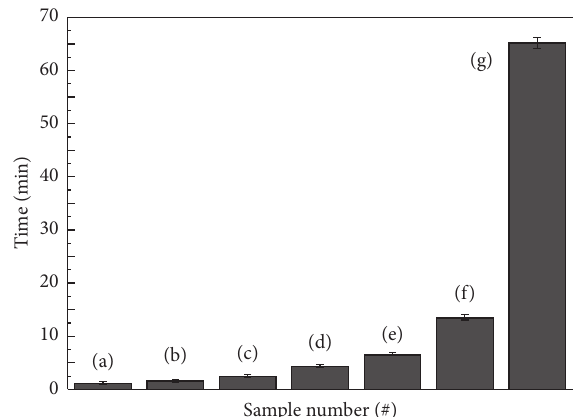
Figure 13: Reacting time for reaching 90% MO degradation rate with different samples: (a) fresh sample, (b) 3-cycle sample, (c) 8- cycle sample, (d) 24h exposed sample under sunlight in air, (e) 24 h exposed sample under sunlight in water, (f) fresh Ag 3 PO 4 , and ((g) fresh N-TiO 2 .activity